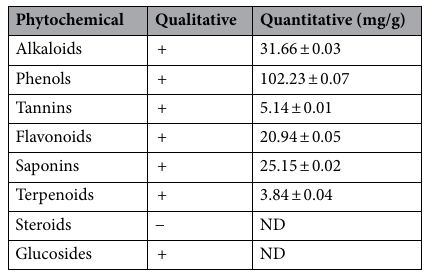
Table 1. Phytochemical analysis of Khaya ivorensis (KI) leaf extract. Key: + = present; − = absent. ND not determined.